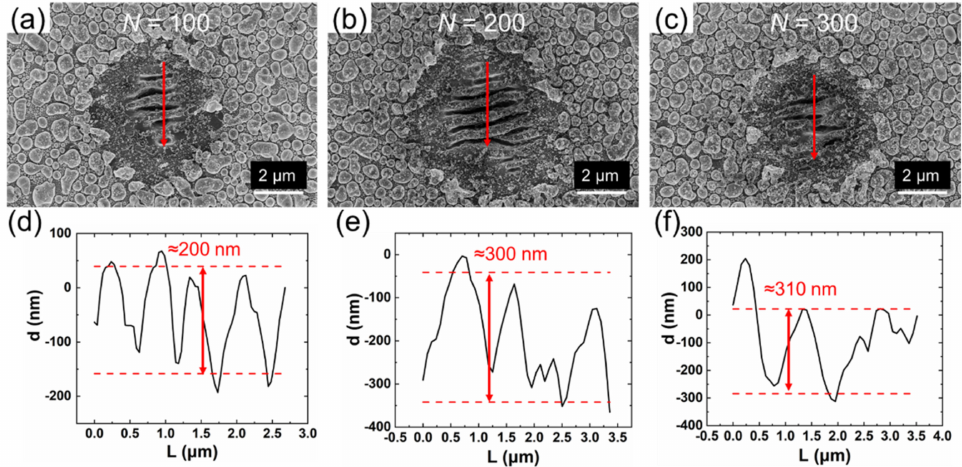
Figure 6. SEM images and AFM profiles of the surface morphologies fabricated on BiIn-Si at a fixed laser fluence of 2.55 J/cm 2 . ( a – c ) correspond to SEM images and ( d – f ) correspond to AFM profiles with different scanning speeds. N is laser pulse